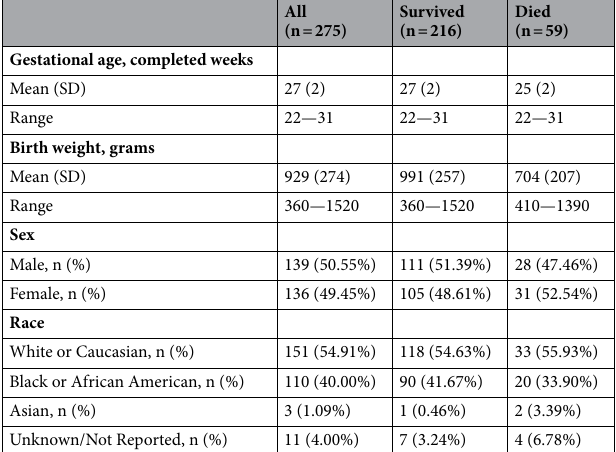
Table 1. Patient demographics.